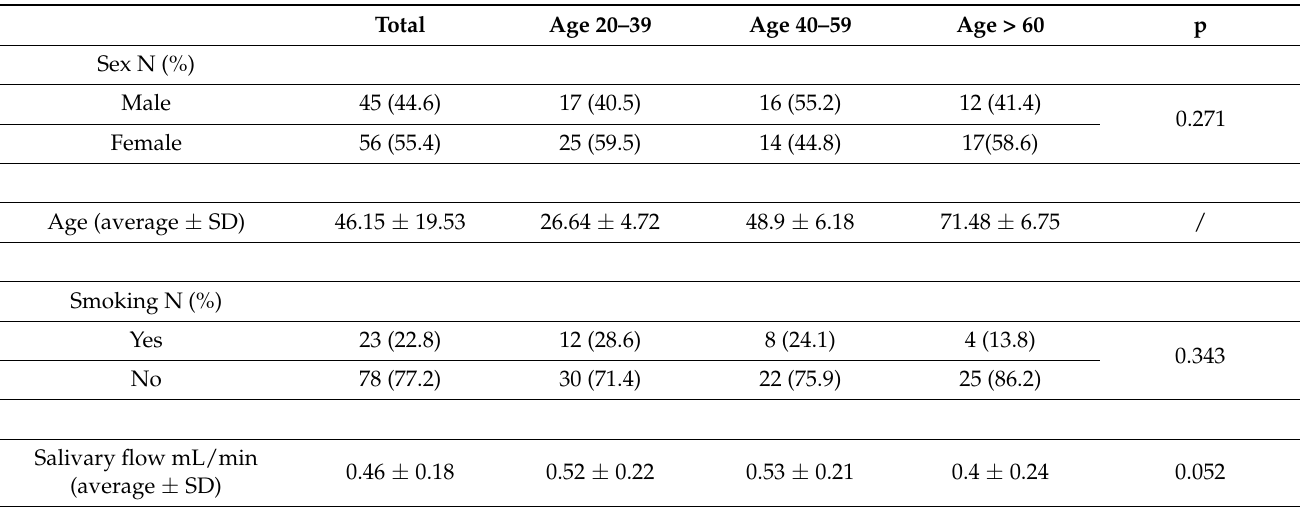
Table 1. Demographic data on